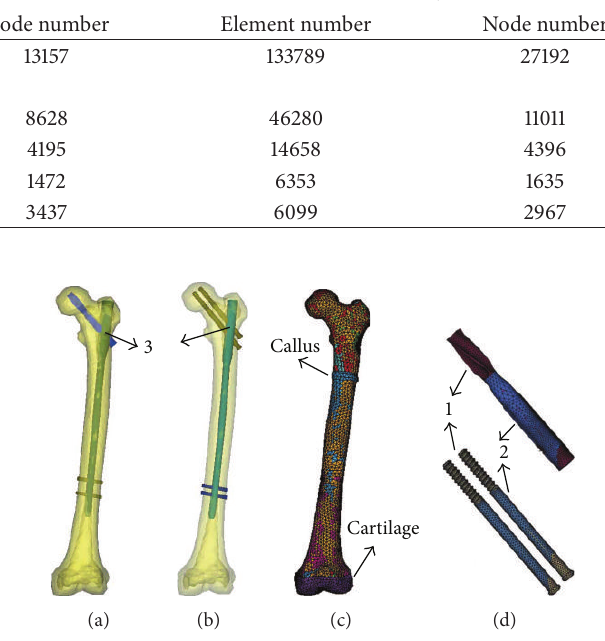
Figure 1: The finite element models (a, b) PFNA-II and A2FN implants fixing the femur models; (c) FE model of the elderly femur with the element-by-element material properties; (d) the femoral neck load carrier (PFNA-II blade/A2FN screws). Three different contact conditions in the bone-implant-construct (1 = contact elements, 2 = sharing common nodes, and 3 = coupling nodes’ degree of